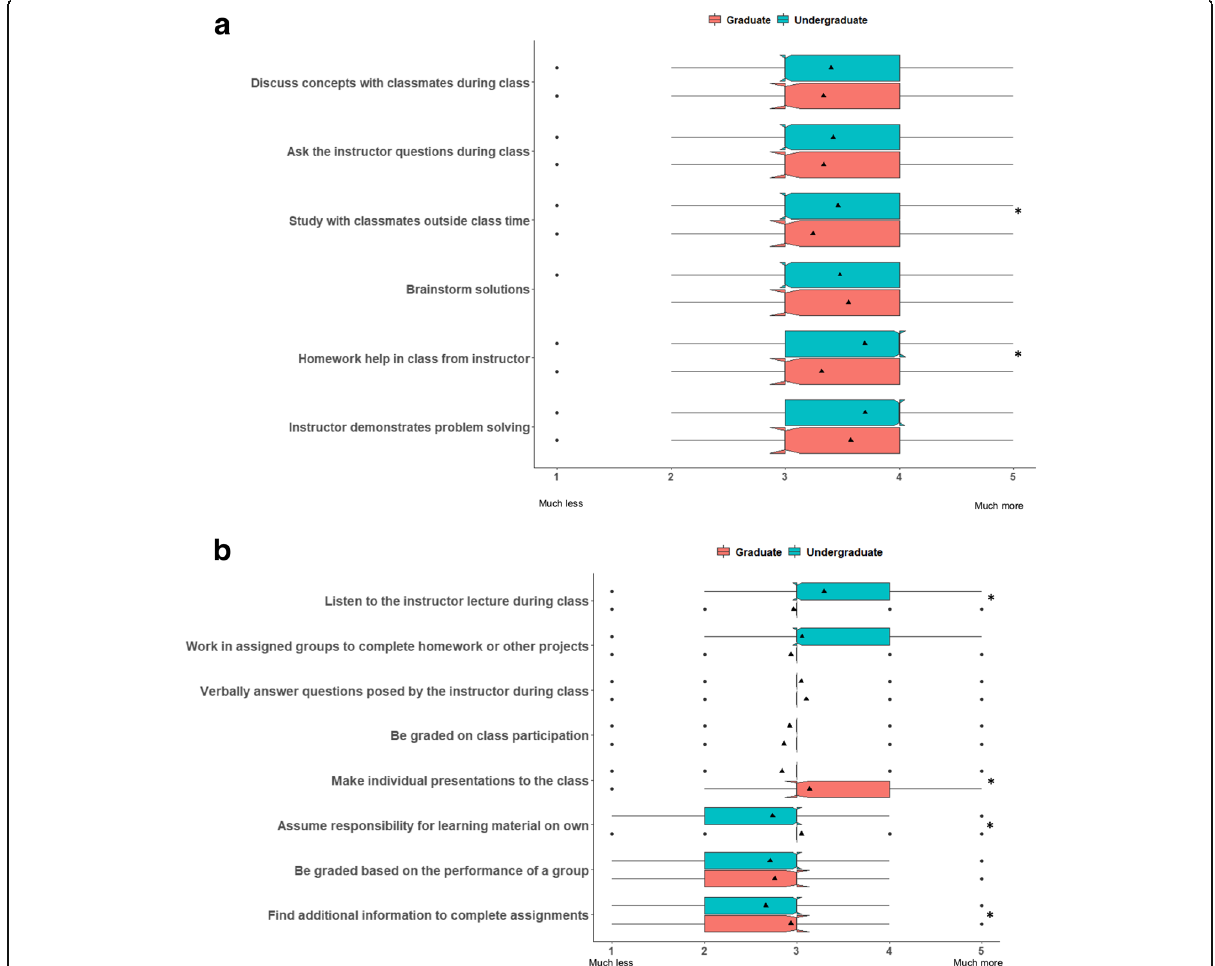
Fig. 3 Box and whisker plots of the most and least desired instructional practices reported by graduate ( n = 161) and undergraduate ( n = 1113) students in STEM classrooms. a Most preferred activities b Least preferred activities. Triangles indicate mean values. *indicates p -values < 0.05. Activities displayed are the top five most and least desired. Reported additional activities reflect the ranking misalignment between graduate and undergraduate